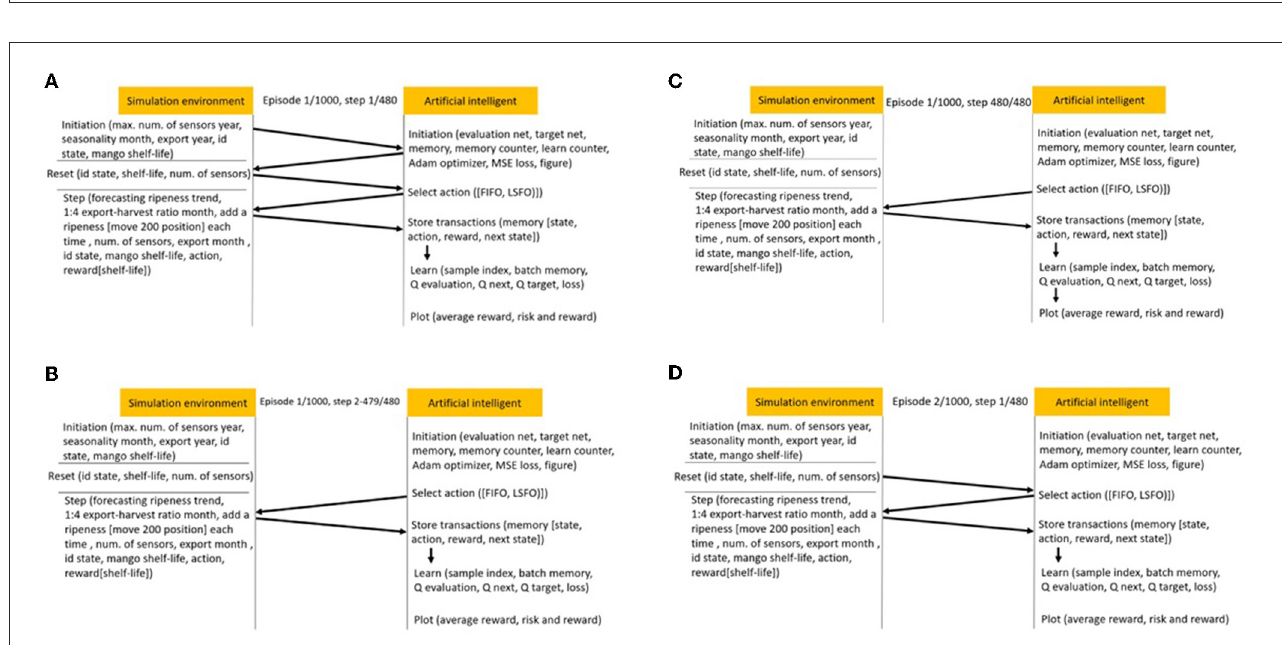
FIGURE3 Deep Q-learning